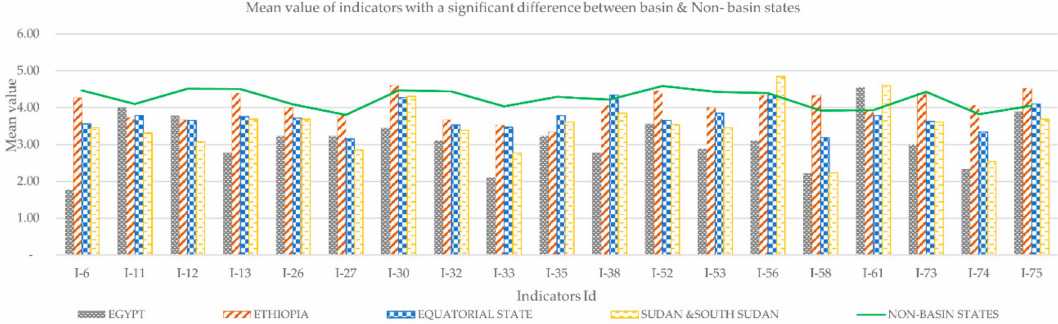
Figure 10. Mean value of all indicators for which individual basin states and non-basin states were statistically significantly di ff erent within, among, and between each other. | drought a ff ected people per year (I-6), Red List Index (I-11), greenhouse gas emissions (I-12), environmental performance index (I-13), transport Index (I-26), ICT index (I-27), population living below poverty line (I-30), education index (I-32), infant mortality rate (I-33), gender development index (I-35), population growth rate (I-38), areas exposed for severe soil erosion (I-52), protected forest area (I-53), wetland area (I-56), estimated cost to conserve erosion areas (I-58), virtual water export (I-61), employment in service provision sector (I-73), revenue and job opportunity from ports (I-74), and water saving by crop pattern modification